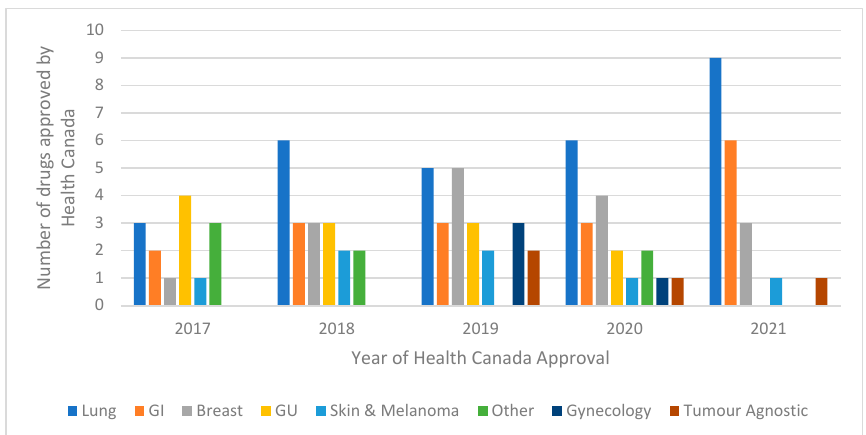
Figure 2. Number of drugs for solid tumour indications approved by Health Canada by year from January 2017 to October 2021. Abbreviations: GI, gastrointestinal; GU, genitourinary.